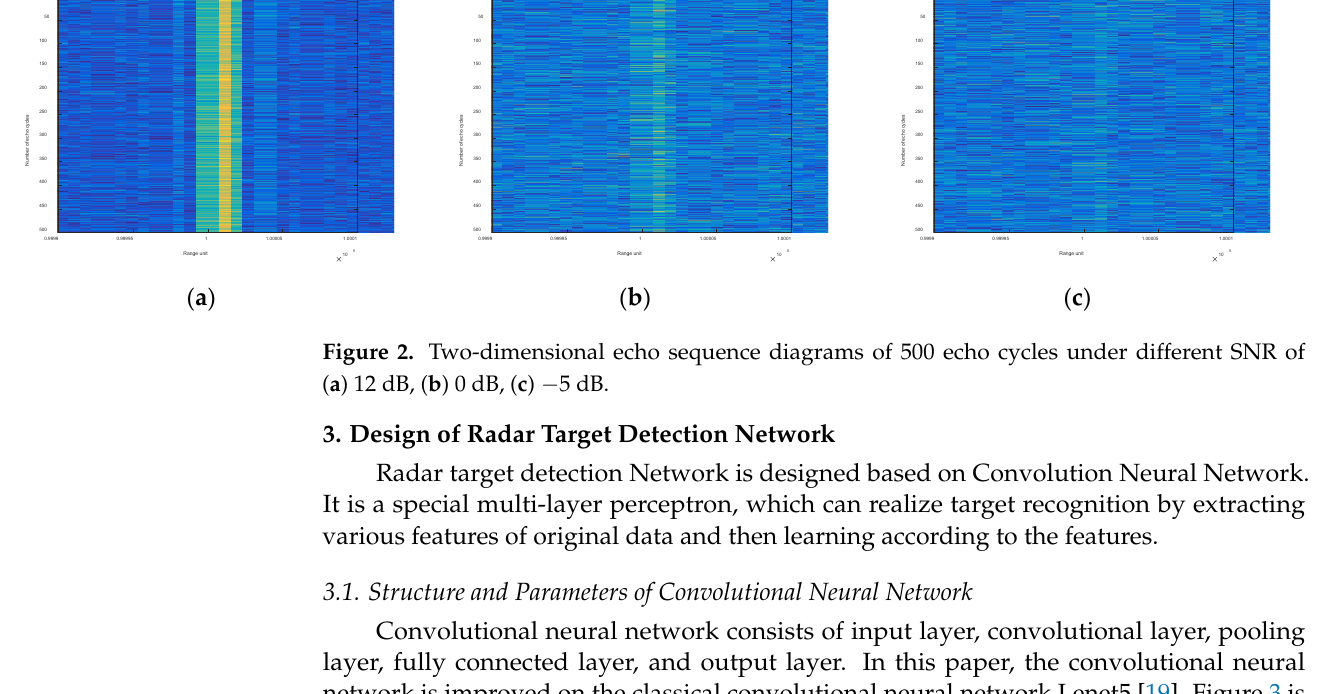
( b ) Figure 1. Echo diagrams of chirps with ( a ) SNR of 12 dB and ( b ) SNR of 0 dB. In the simulation experiment, the amplitude, bandwidth, pulse width, and fre- quency modulation slope of the transmitted signal are the same, and the distribution of Gaussian white noise in each frame is changed under the condition that the SNR of the echo remains unchanged. Under the condition of the same SNR, echo signals of multiple cycles can be collected to form a two-dimensional echo sequence diagram, the abscissa of the two-dimensional echo sequence diagram is the range unit, and the ordinate is the